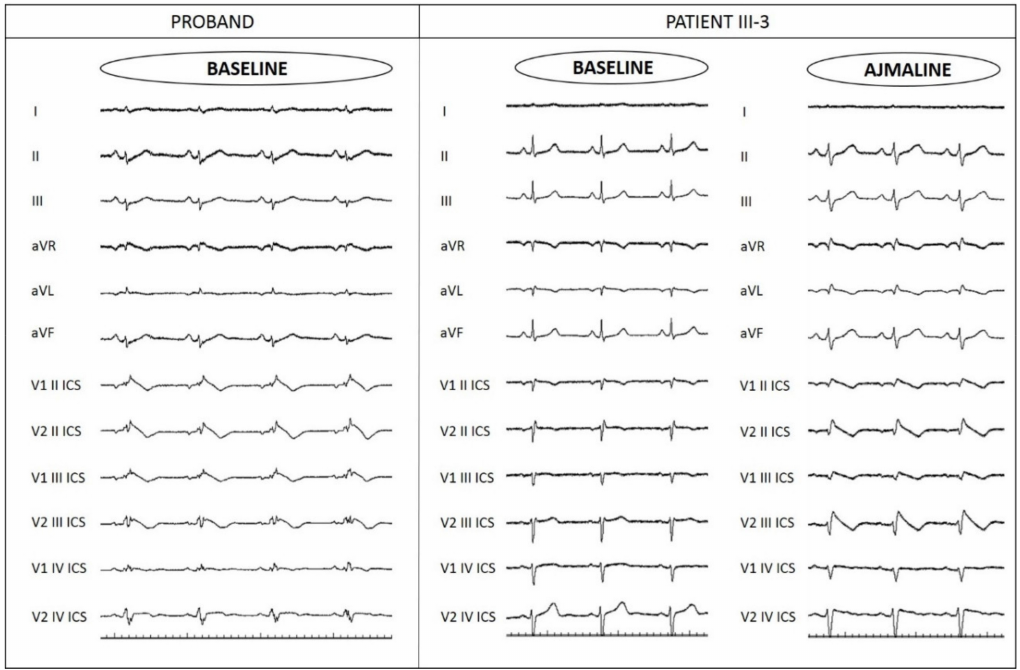
Figure 2. Left panel shows proband’s ECG with a spontaneous type 1 BrS ECG pattern. Right panels show patient III-3, one of the proband’s sisters, with an ajmaline-induced type 1 BrS ECG